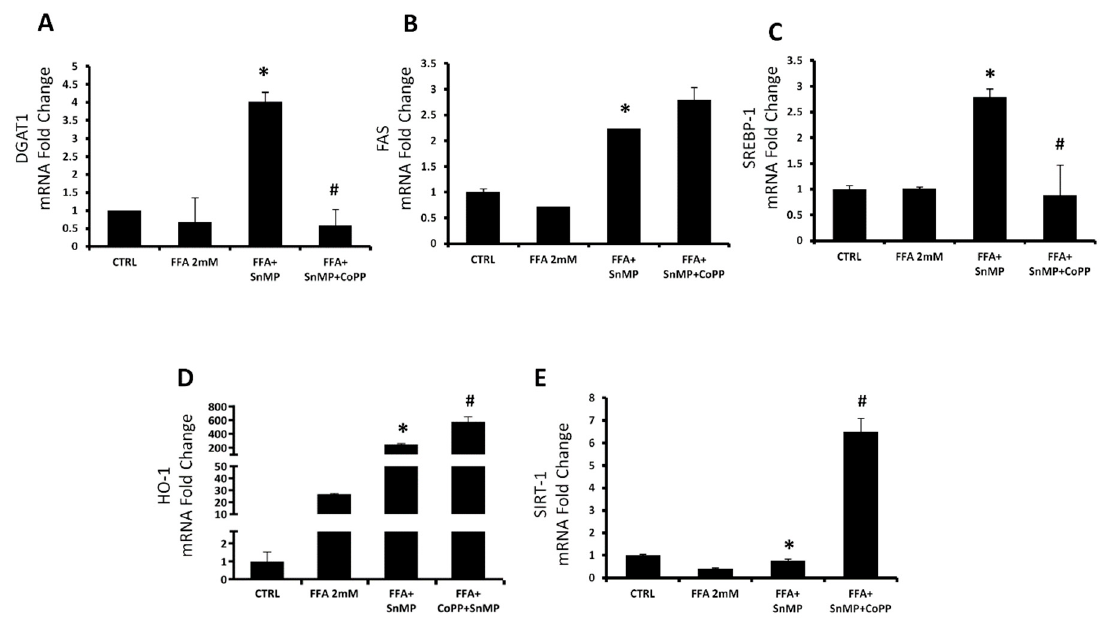
Figure 2. mRNA expression of DGAT1 ( A ) FAS, ( B ) SREBP-1, ( C ) HO-1, and ( D ) SIRT1, ( E ) of HepG2 control cells, cells treated with FFA 2 mM and cells treated with SnMP 5 uM alone or in combination with CoPP 5 uM. Results are mean ± SD, * p < 0.05 vs. FFA 2mM, # p < 0.05 vs. FFA+SnMP .